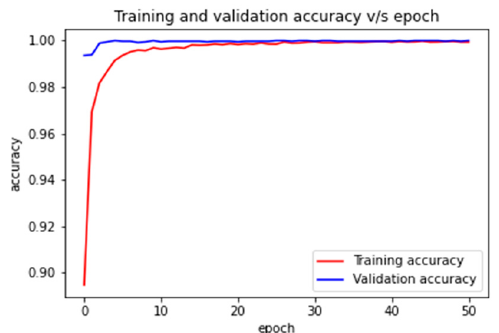
Figure 7. Accuracy vs. epoch curve for the proposed TL-based bearing FD approach.